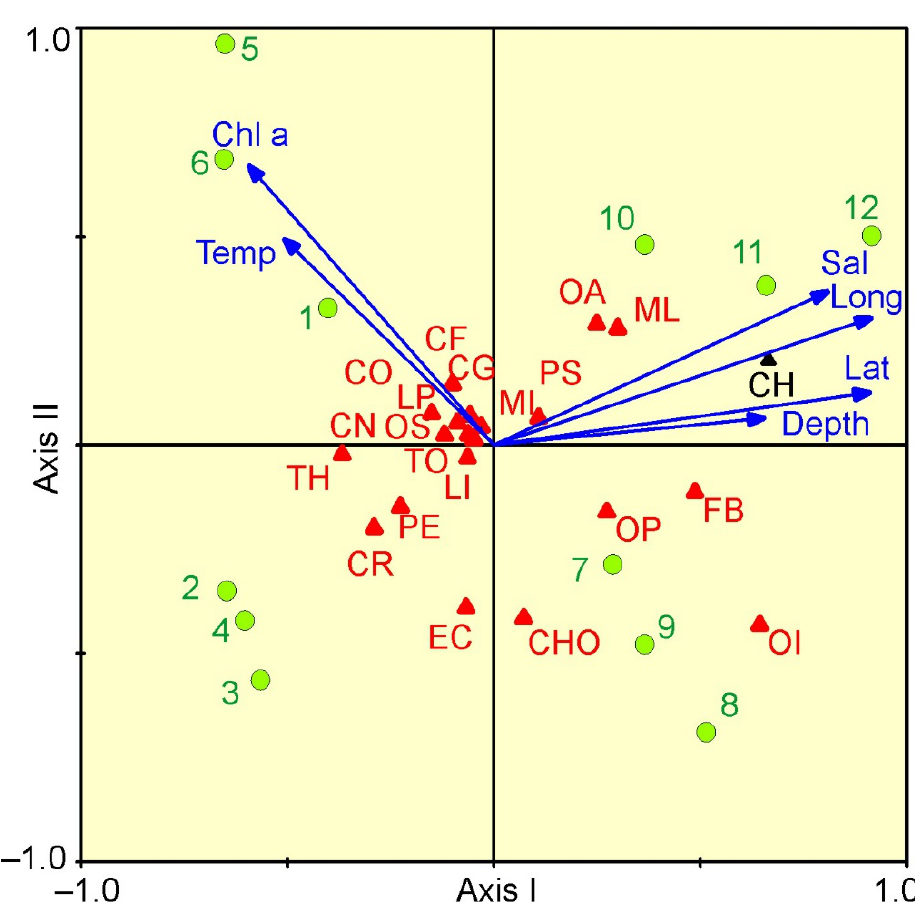
Figure 6. CCA for the most abundant mesozooplankton taxa/groups and environmental parameters of samples collected in the eastern Barents Sea in May 2016: CF— Calanus finmarchicus ; CG— Calanus